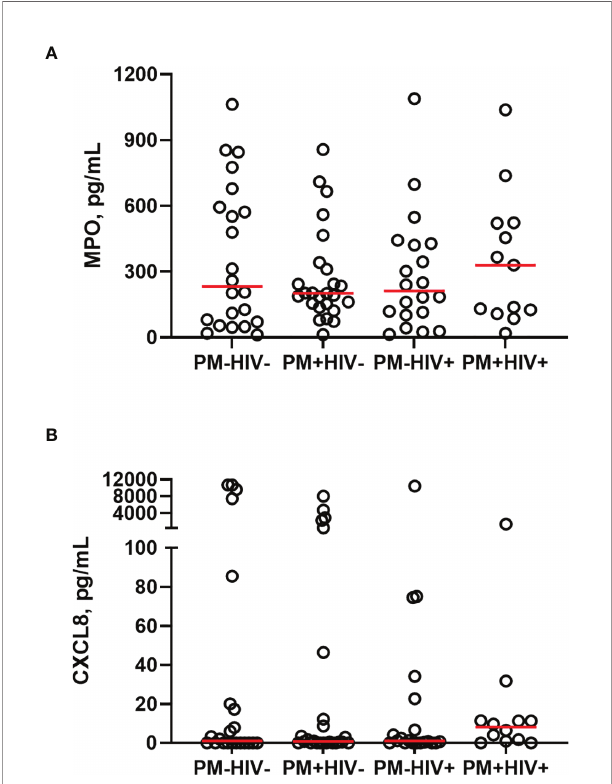
FIGURE 5 | Peripheral blood MPO and CXCL8levelsdonot change as a function of placental malaria and HIV seropositivity. Peripheral plasma samples from paucigravid women were analyzed for (A) MPO and (B) CXCL8levels by bead array.No statistically signi fi cant differences among the groups are evident (Kruskal-Wallistest with post-hoc group-wise comparisonsby Dunn ’ s multiple comparisonstest).HIV-/PM-, n = 22; HIV-/PM+,n = 25; HIV+/PM-, n = 20; HIV +/PM+,n = 14 (MPO), n = 13 (CXCL8.)Groups as de fi nedin Figure 2